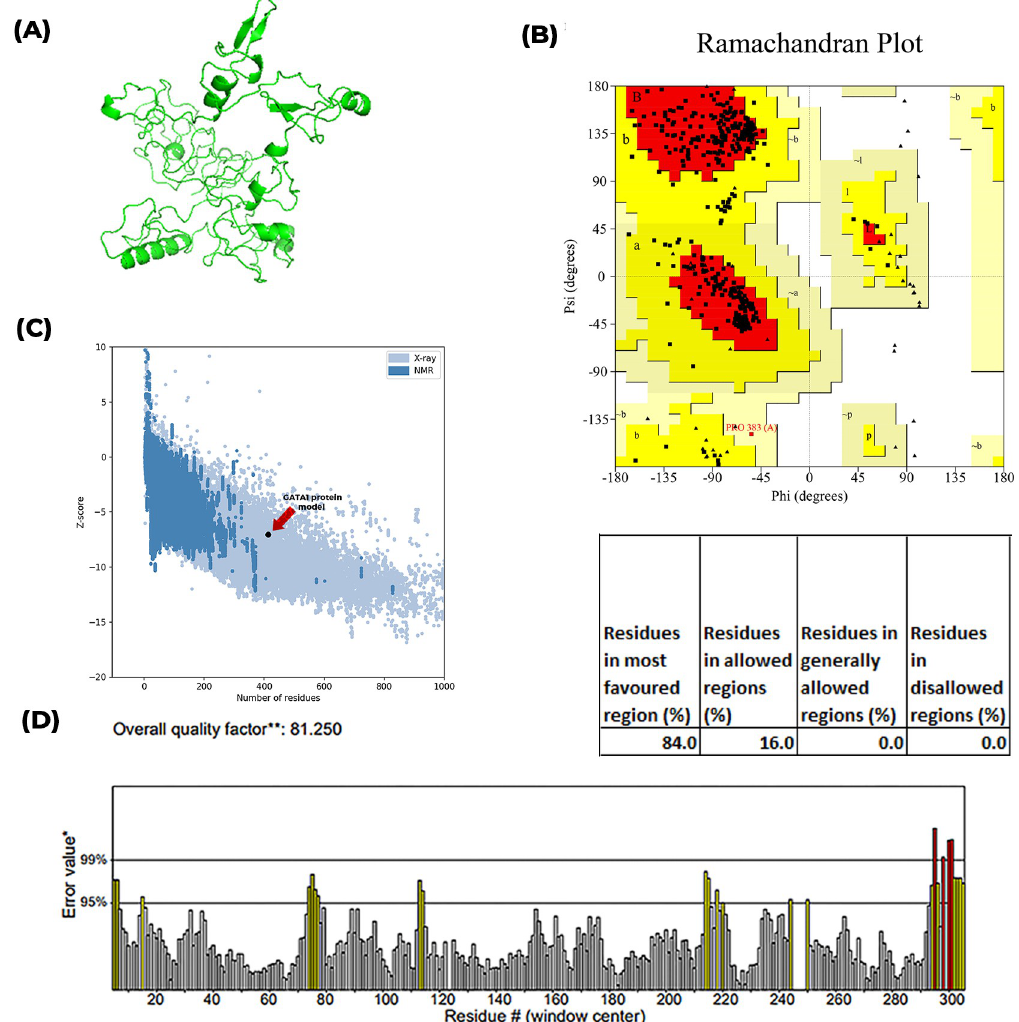
Fig 4. Structure analyses of ab initio GATA1 modelled protein. (A) Predicted 3D structure of the protein (B) Ramachandran plot of the structure (C) Z-score plot from PROSA (D) Residual error value plot from ERRAT2.